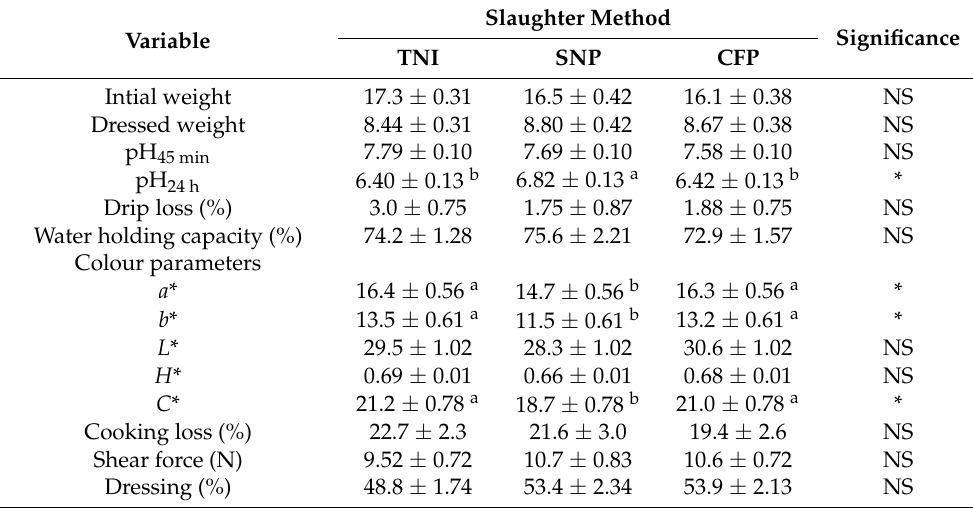
Table 1. Effects of indigenous slaughter methods on physico-chemical attributes of goat